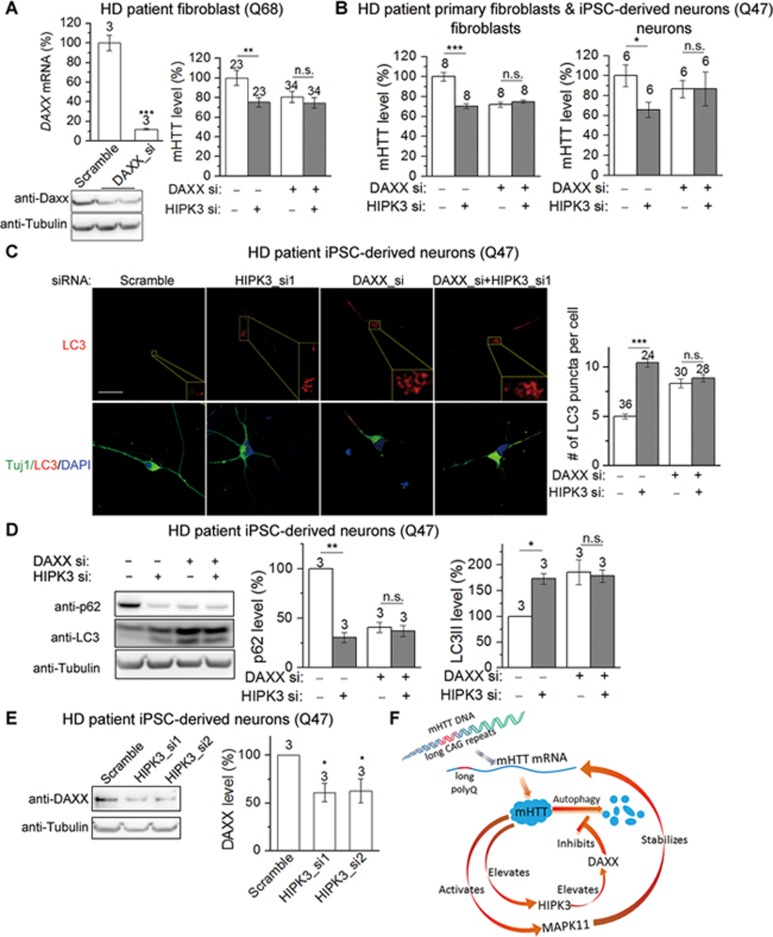
Hipk3 regulates mHtt levels via DAXX. (A) Left, RT-qPCR and western blots confirming the knockdown of DAXX in HD patient fibroblasts (Q68) by its siRNA. Right, mHTT levels in HD patient fibroblasts (Q68) measured by HTRF using the antibody pair 2B7/MW1, after transfection of the indicated siRNAs. Transfection of the DAXX siRNA blocked the effect of knocking down HIPK3. (B) mHTT levels in HD patient (Q47) primary fibroblasts (left) or HD patient iPSC-derived neurons (right) measured by HTRF using the antibody pair 2B7/MW1, after transfection of the indicated siRNAs. Transfection of the DAXX siRNA blocked the effect of knocking down HIPK3. (C) Representative images and quantification of endogenous LC3II puncta in patient iPSC-derived neurons (Q47) transfected with the indicated siRNAs. Scale bar, 20 μm. The quantification of the puncta was performed blindly, the boxed regions have been magnified and exhibited at the lower right corner for better view of the puncta, but the counting was not limited to the boxed regions. The statistical analysis was performed by two-way unpaired t tests. (D) Representative western blots and quantification of p62 and LC3 blots of patient iPSC-derived neurons (Q47) transfected with the indicated siRNAs. (E) Representative western blots and quantification of DAXX in patient iPSC-derived neurons (Q47) transfected with the indicated siRNAs. (F) A model illustrating the positive feedback loop mediating MAPK11 and HIPK3's effect on mHTT levels. For all bar plots, data represent mean and SEM. The statistical analysis was performed by two-way unpaired t tests for A to D, and by one-way ANOVA followed by Dunnett's post hoc tests for E and F. *P < 0.05; **P < 0.01; ***P < 0.001; ns, P > 0.05.